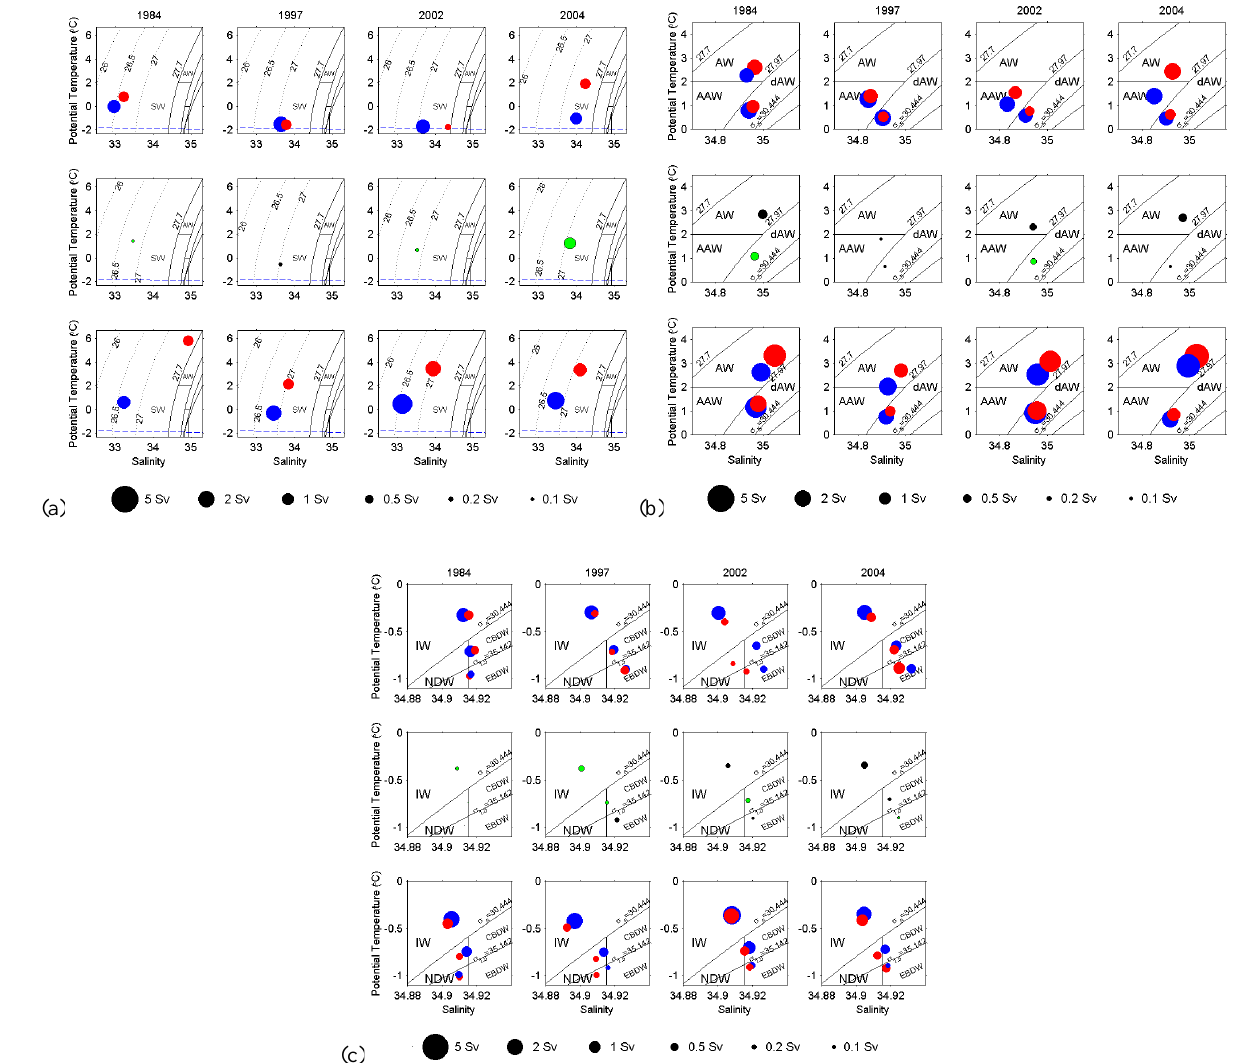
Fig. 8. θ S volume diagrams with mean potential temperatures and salinities for different water masses for each year . The mean potential Fig. 8c temperatures and salinities of the transports are given by the positions of the circles and the volume transports by the size of the circles. Northward transports are red and southward blue. Northern section is shown in the top panel, the divergence (green) or convergence (black) of each water mass in the centre and the 79 ◦ N section in the bottom panel. The water masses used in the computations are (a) surface water SW ( σ θ < 27.70), (b) AW (27.70 ≤ σ θ < 27.97, here further separated by 0 ◦ C isotherm into AW and AAW) and dAW ( σ θ ≥ 27 . 97, σ 0 . 5 < 30.444, θ > 0 ◦ C), (c) intermediate water (IW) (separated by 0 ◦ C isotherm from dAW) and deep waters (DWI ( σ 0 . 5 ≥ 30 . 444, σ 1 . 5 < 35.142) and DWII ( σ 1 . 5 ≥ 35 . 142)). Limits are shown for NDW = Nordic Seas Deep Water, CBDW = Canadian Basin Deep Water and EBDW = Eurasian Basin Deep